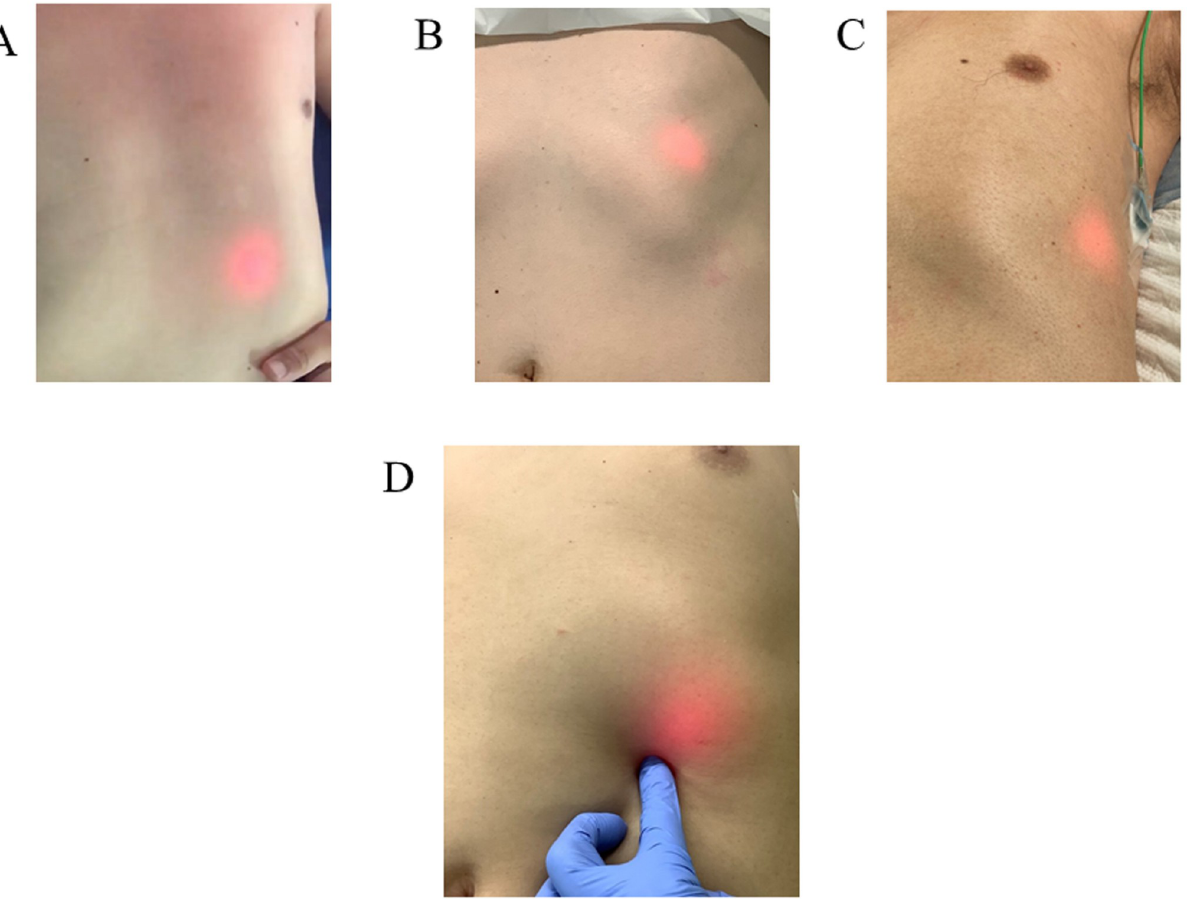
Fig 2. Positive sign of biologically transparent (BT) light, which showed several patterns. The BT light was detected in the epigastric area of the center site (A), the upper site (B), the lateral site (C), and using finger pressure (D).